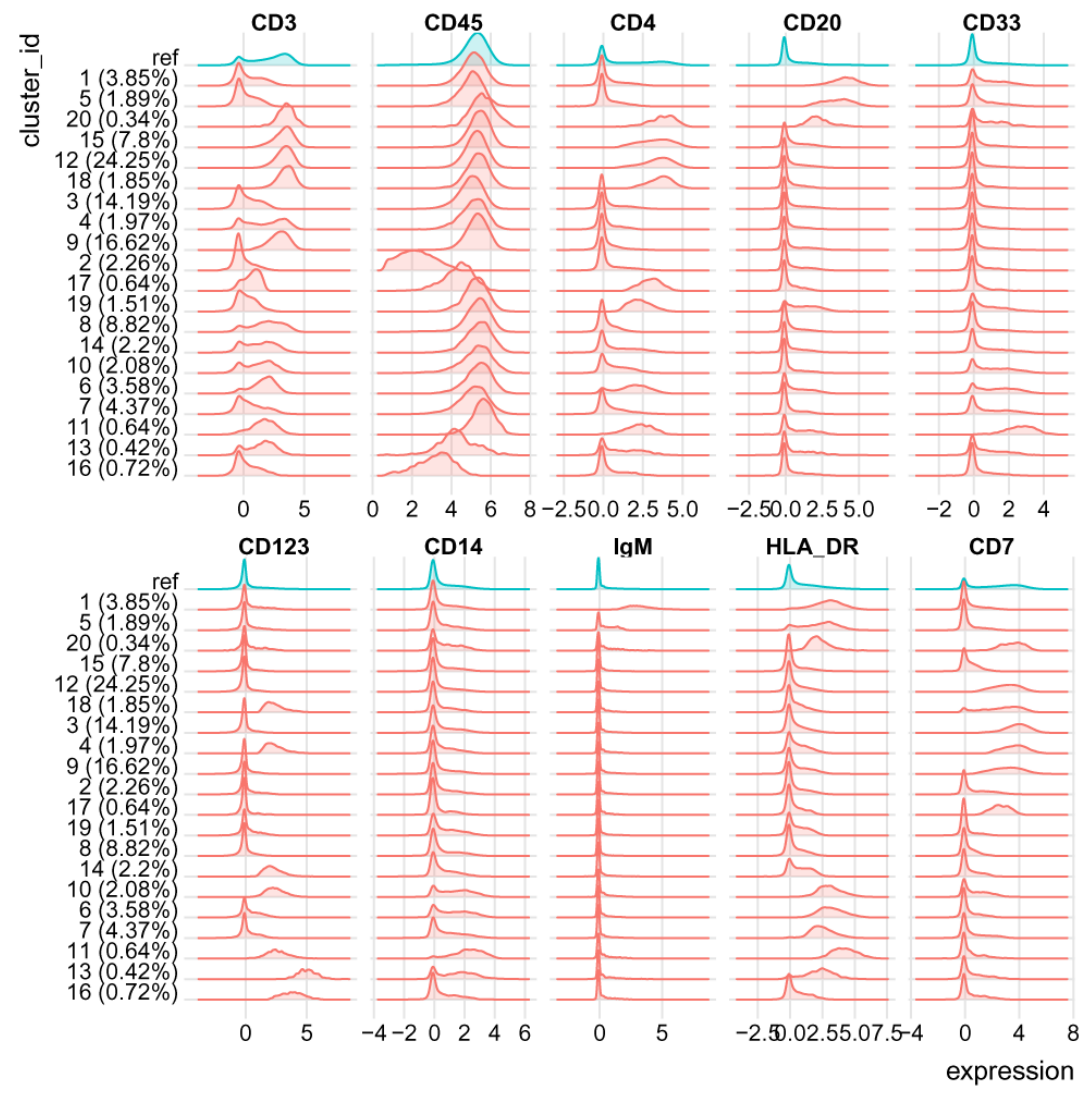
Figure 7. Distributions of marker intensities (arcsinh-transformed) of the 10 lineage markers in the 20 cell populations obtained with FlowSOM after the metaclustering step with ConsensusClusterPlus (PBMC data). Red densities represent marker expression for cells in a given cluster. Blue densities are calculated over all the cells and serve as a reference.